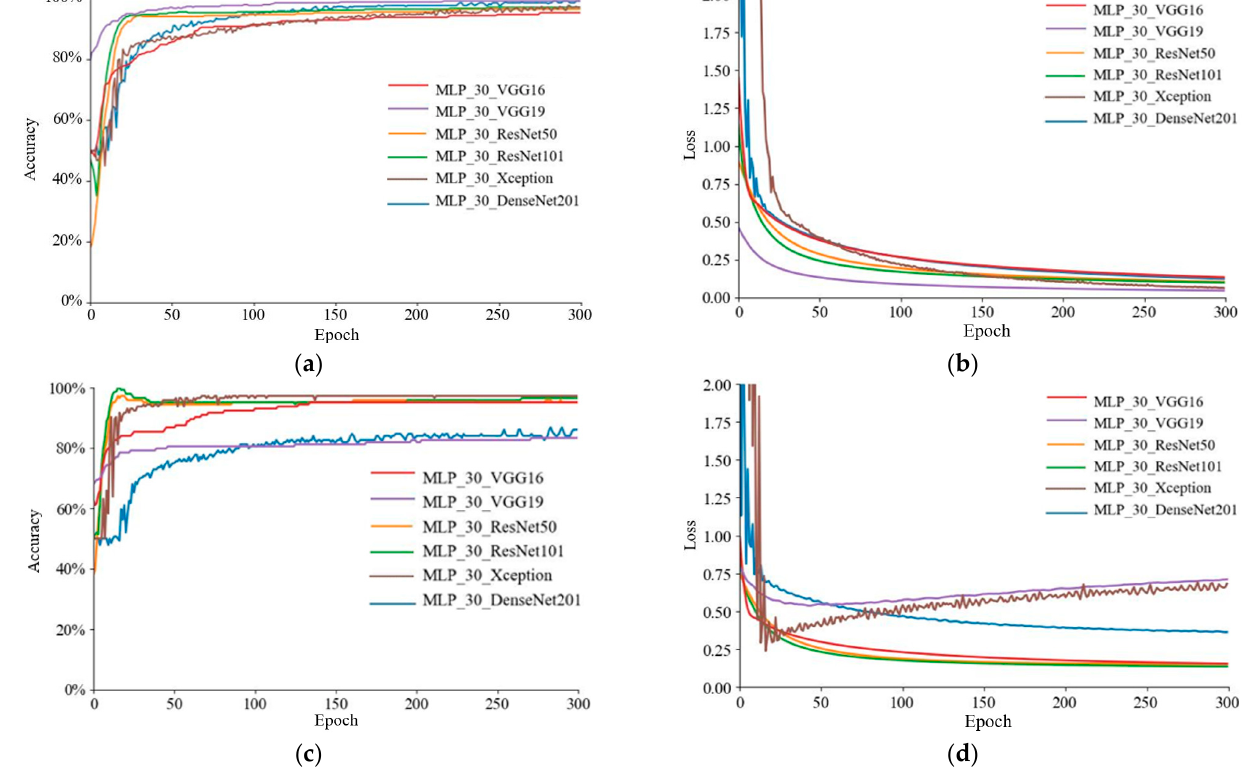
Figure 9. Training curves for six fusion models: ( a ) training accuracy curve; ( b ) training loss curve; ( c ) validation accuracy curve, and ( d ) validation loss curve.